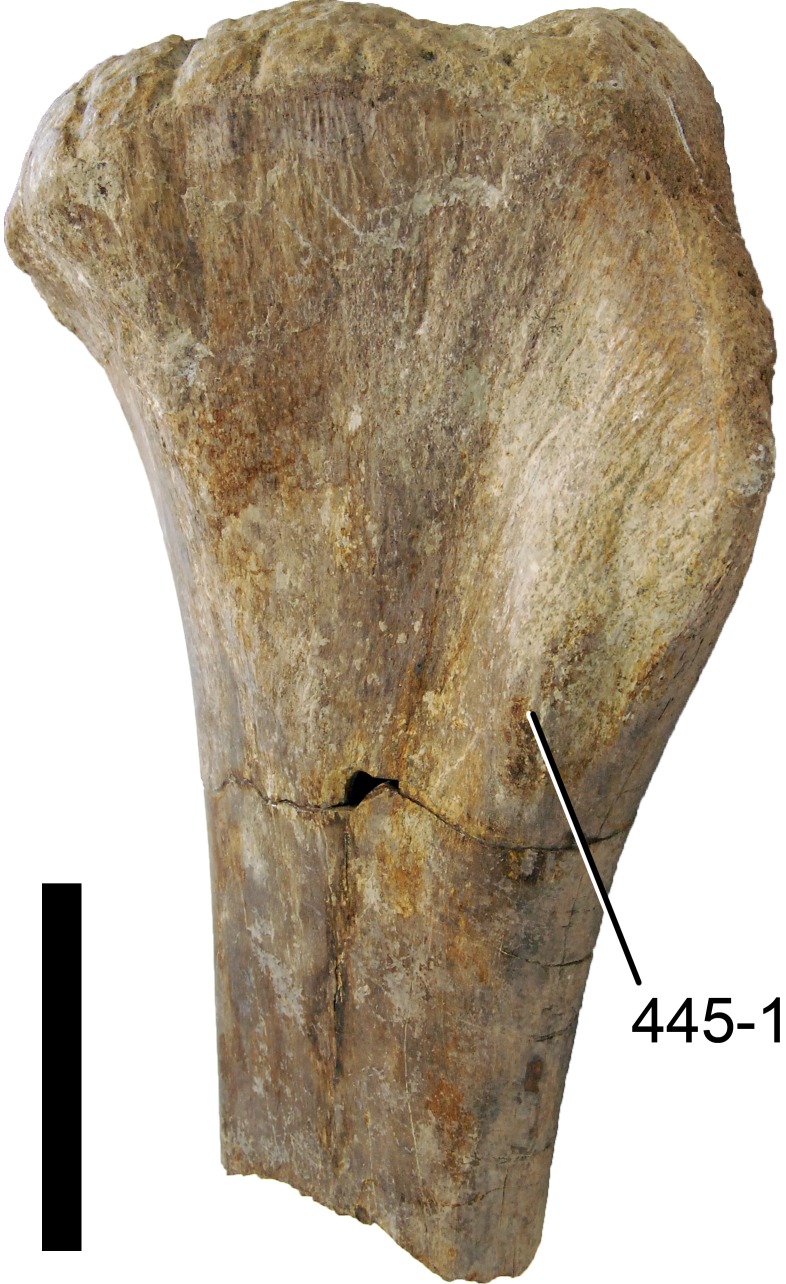
Proximal end of the tibia of Suuwassea emilieae ANS 21122.Proximal end of the tibia of Suuwassea emilieae ANS 21122 in posterolateral view, showing the distinct fibular trochanter on the posterior surface of the cnemial crest (C445-1). Scale bar = 10 cm.